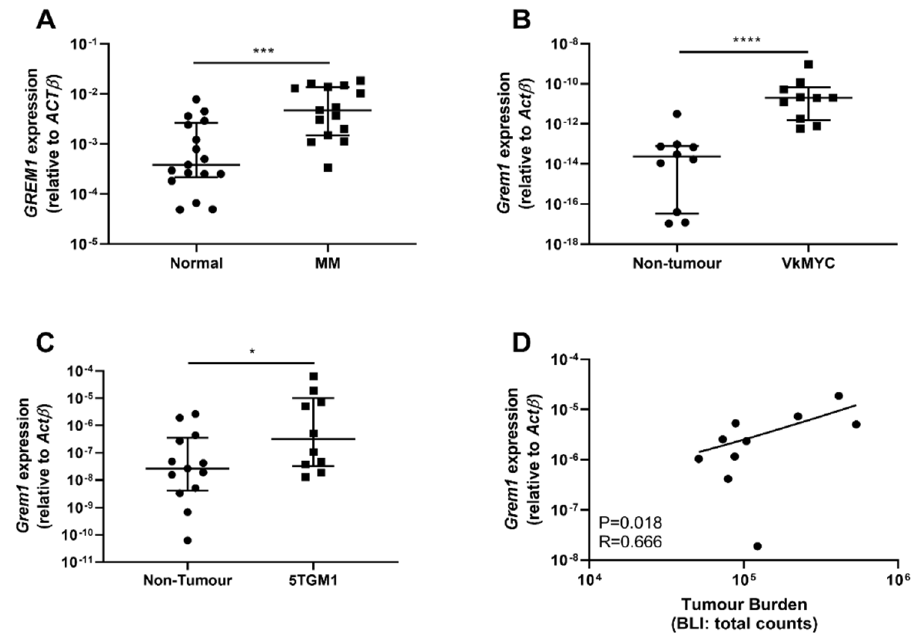
Figure 1. GREMLIN1 (GREM1) expression is elevated in primary stromal cultures from multiple myeloma (MM) patients and the compact bone of tumor-bearing KaLwRij mice. RNA was extracted from stromal cells ex vivo cultured from bone marrow (BM) trephine samples from age- and gender-matched normal donors and MM patients and the expression of GREM1 ( A ) was analyzed by real-time PCR. Data presented as mRNA expression normalized to β -Actin ( ACTB ), median ± interquartile range, Normal; n = 17 and MM; n = 15, *** p < 0.001, Mann–Whitney test. Grem1 expression in compact bone isolated from the long bones of nontumor- and ( B ) Vk*MYC tumor-bearing C57BL6 mice ( n = 10), and ( C ) 5TGM1 tumor-bearing (MM) KaLwRij mice (Nontumor; n = 13 and Tumor-bearing; n = 10) was analyzed by real-time PCR. Graph depicts Grem1 expression relative to β -Actin ( ActB ), median ± interquartile range, * p <0.05, **** p < 0.0001, Mann–Whitney test. ( D ) Grem1 expression in the BM stroma isolated from the compact bone of the hindlimbs of KaLwRij tumor-bearing mice was correlated with the tumor burden in the respective limbs, as detected by bioluminescent imaging (BLI). Graph depicts Grem1 expression ( y -axis) vs. tumor burden ( x -axis), n = 10, Pearson correlation, p < 0.05, r = 0.666.